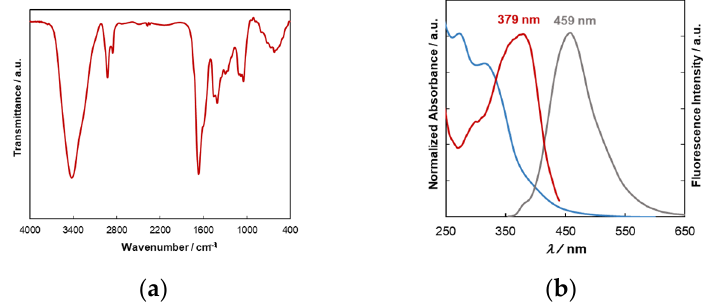
Figure 1. FTIR (KBr) ( a ) and UV-Vis (blue), excitation (red, monitored at 460 nm) and emission (gray, λ exc = 380 nm) spectra ( b ) of TWCDs.